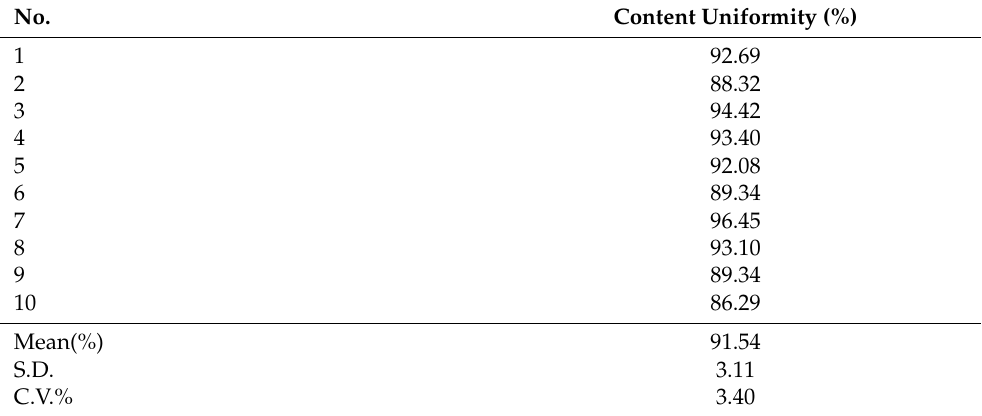
Table 2. The results of content uniformity for optimal dropping pill formulation ( n = 10).